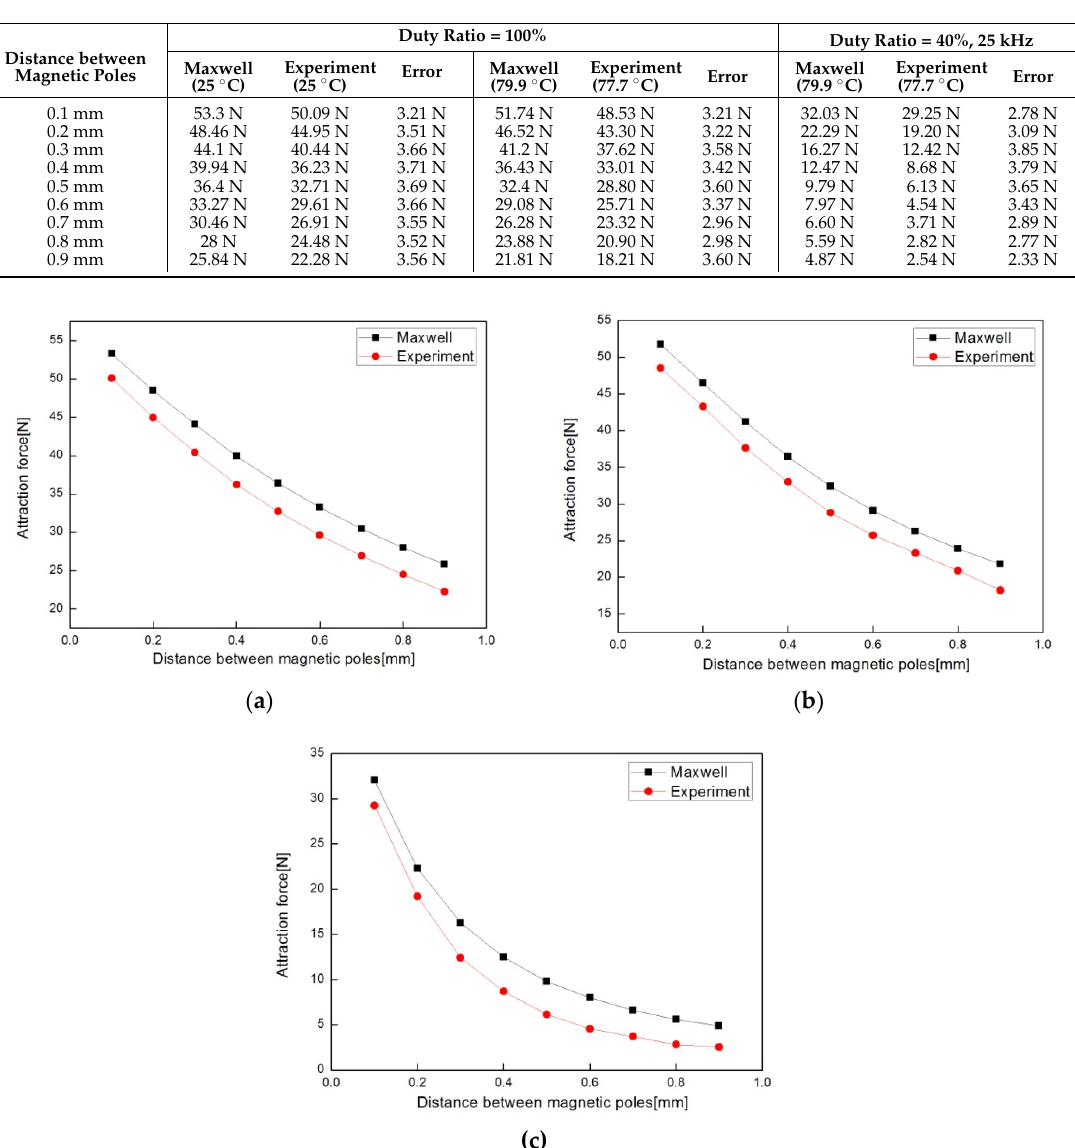
Figure 15. Comparison of attraction force between analysis and experiment: ( a ) Ambient temperature, duty ratio = 100%; ( b ) Saturation temperature, duty ratio = 100%; ( c ) Saturation temperature, duty ratio = 40%.